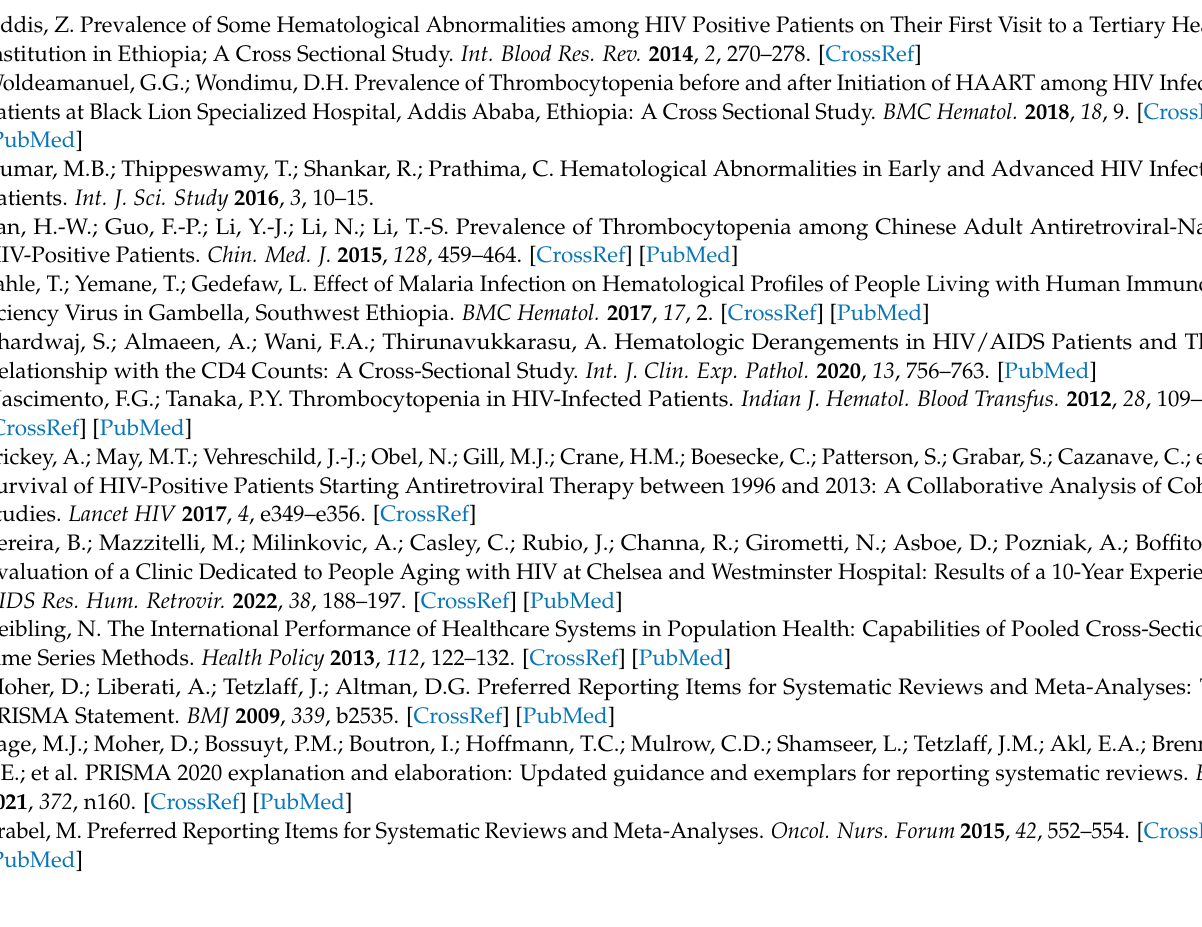
Table S2: Preferred Reporting Items for Systematic Reviews and Meta-Analyses (PRISMA) checklist; Table S3: Characteristic of study included in the